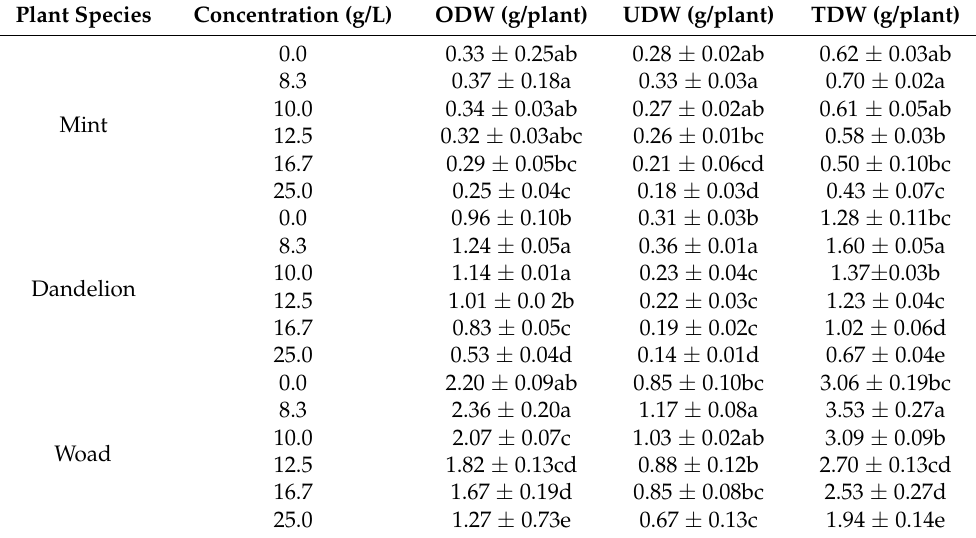
Table 2. Effect of different concentrations of the aqueous leaf extracts of fig tree on the seedling growth of mint, dandelion, and